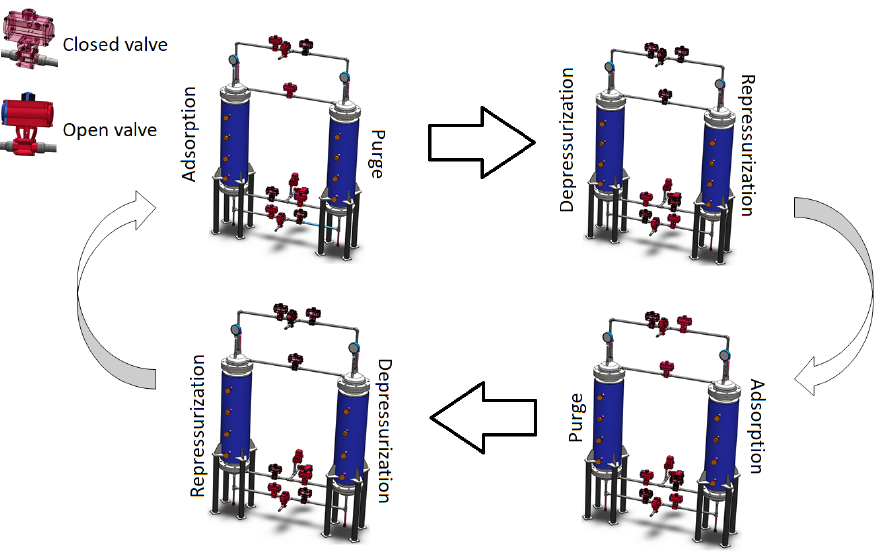
Figure 2. PSA operating